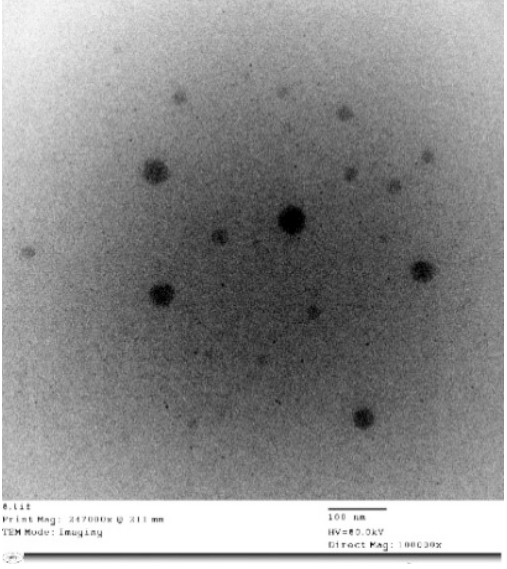
Molecules 2021 , 26 , x FOR PEER REVIEW Figure 2. Transmission electron micrographs of different nano-hexosomal dispersions of C. lemon .